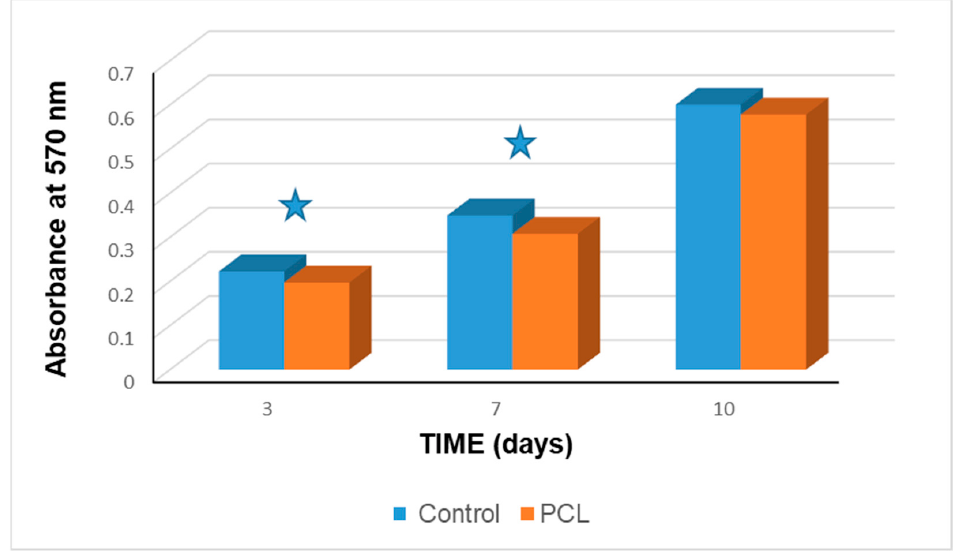
Figure 5. Cell viability (Alamar blue™ cell metabolic assay) in control and in 3D PCL scaffolds groups. Star symbol indicates statistically significant difference between groups ( p < 0.01).